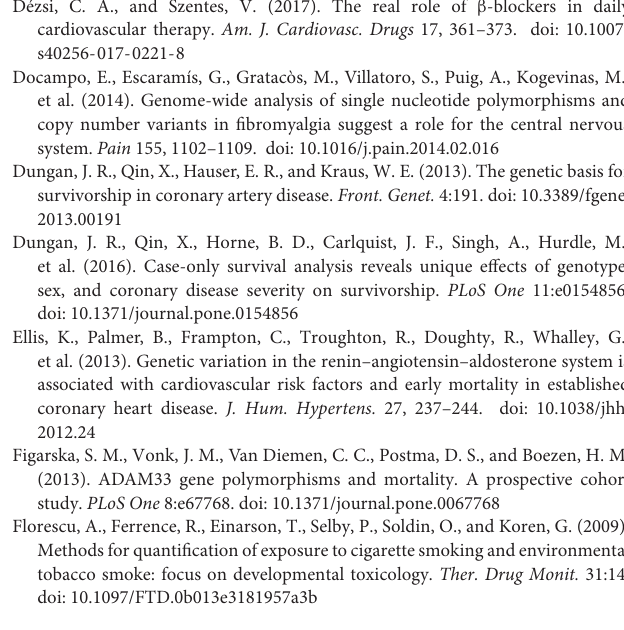
Supplementary Table 2 | Top 93 discovery SNPs. ∗ Base model adjusting for age, sex, and four principal components of ancestry; p(adj) , clinically adjusted model controlling for body mass index (BMI), history of smoking, type 2 diabetes, hyperlipidemia, hypertension, creatinine, and ejection fraction. Bold indicates GWAS-level significance p = 10 − 8 . Supplementary Table 3 | Details of 1229 SNPs evaluated for effect size